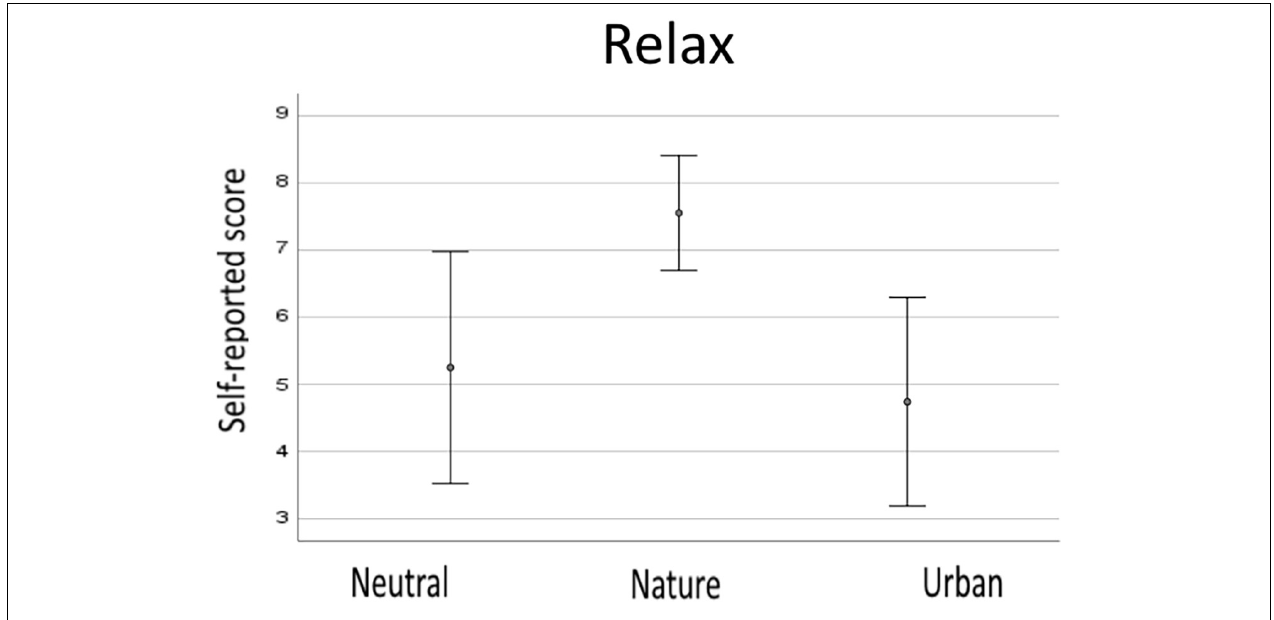
FIGURE 2 | Descriptive data from subjective responses for neutral, nature, and urban experimental condition. Error bars show standard deviations (SD).